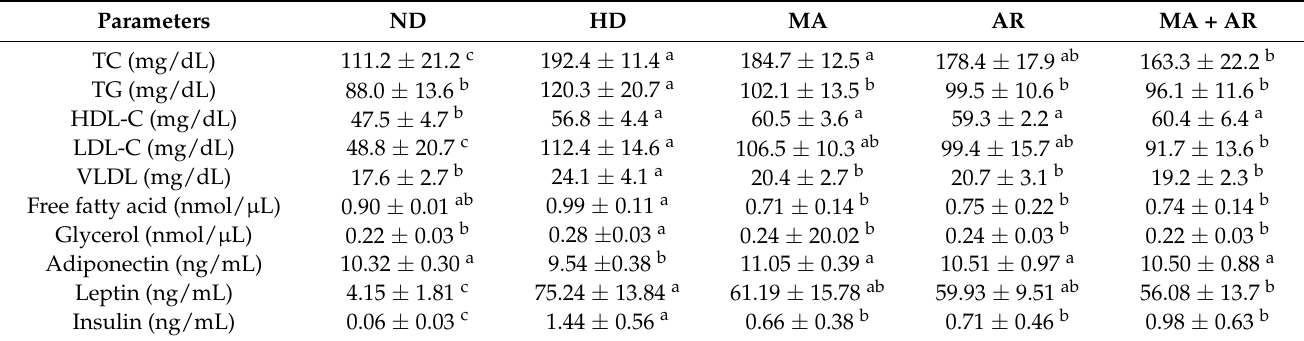
Table 2. The effect of MA, AR on serum profiles in the experimental mice.